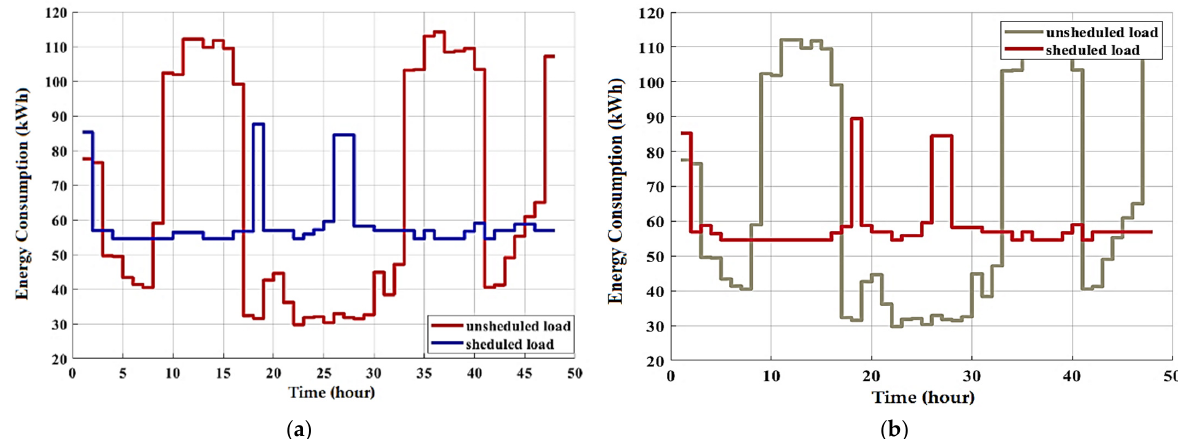
Figure 6. Load profile for ( a ) non-shiftable loads, ( b ) shiftable loads, and ( c ) unscheduled loads.